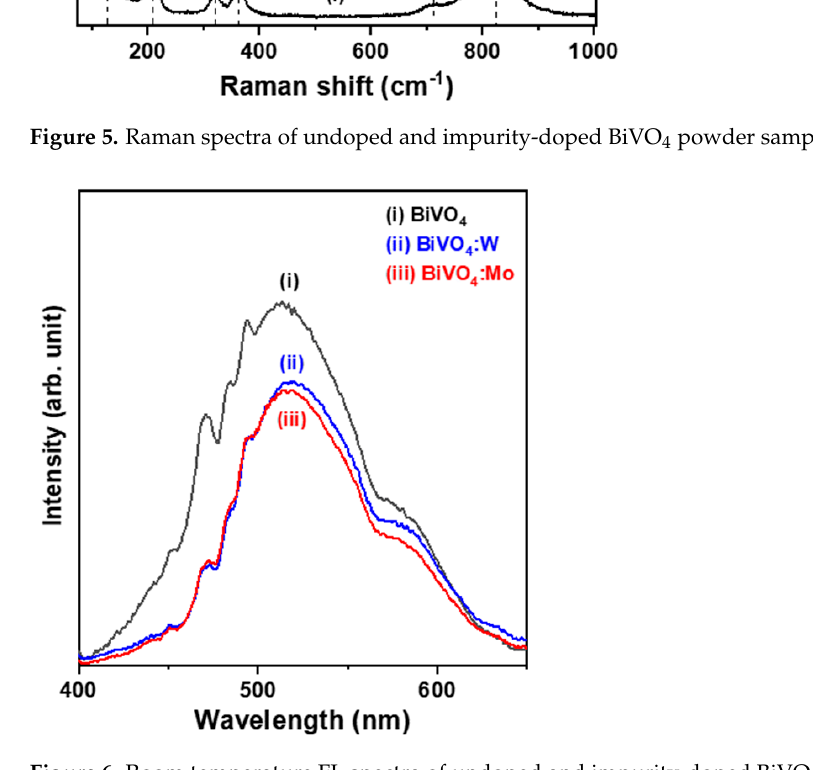
Figure 6. Room temperature FL spectra of undoped and impurity-doped BiVO 4 powder samples. The BiVO 4 -based powder samples exhibited similar absorption spectra in the wave- length range of 300–800 nm, as shown in Figure 7a. Each absorption curve showed low absorption in the wavelength range of 600–800 nm; displayed a steep shape absorption feature, representing the absorption edge, within the range of 450–520 nm; and showed a strong absorption ability in the measured wavelength region shorter than 450 nm. The nature of the absorption edge is attributed to the band-to-band transition of direct bandgap semiconductor materials, whereas the absorption bands contained a slight tail extending to the right-sides until approximately 550 nm. This feature resulted from defects in the BiVO 4 -based crystals. In addition, it was found that the absorbance magnitudes of the impurity-doped powder samples (curves (ii) and (iii)) were twice as high as that of the un-doped powder sample (curve (i)) in the 600–800 nm region due to the former exhibiting an irregular particle morphology and possessing a much larger specific surface